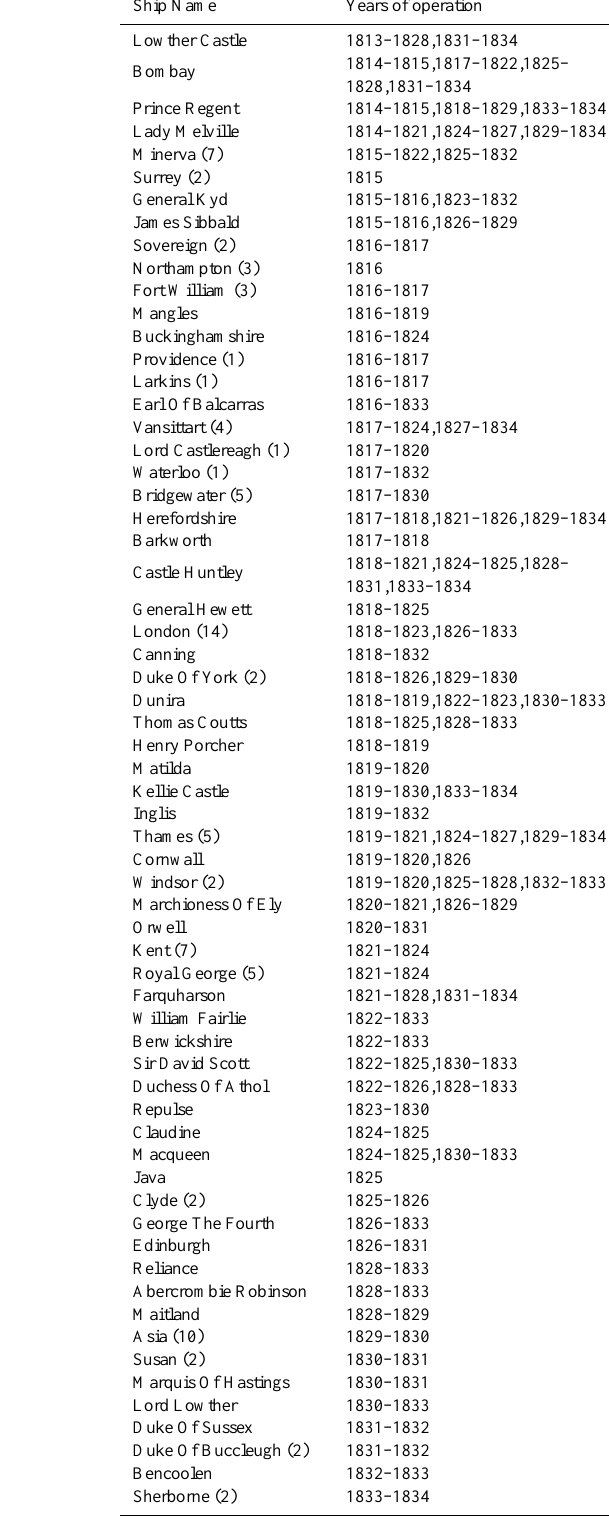
Table 3. Ships from which observations were taken (2 of 2 – starting dates 1803 to 1833). Table 3.